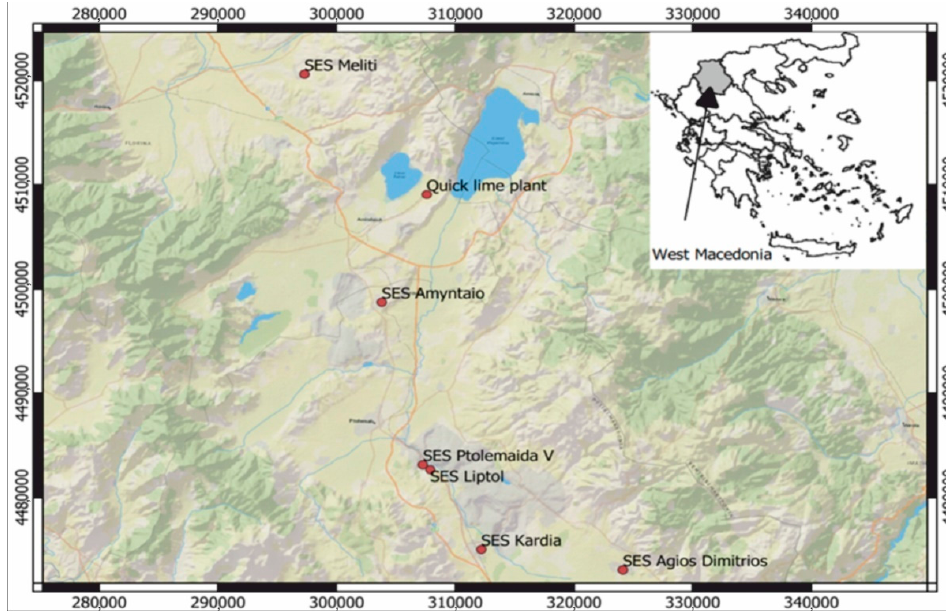
Figure 3. Locations of power and lime plants in the Western Macedonia. Table 4. Data on the emissions from the operational power plants of the West Macedonia in 2019. (Source: Public Power Corporation S.A,